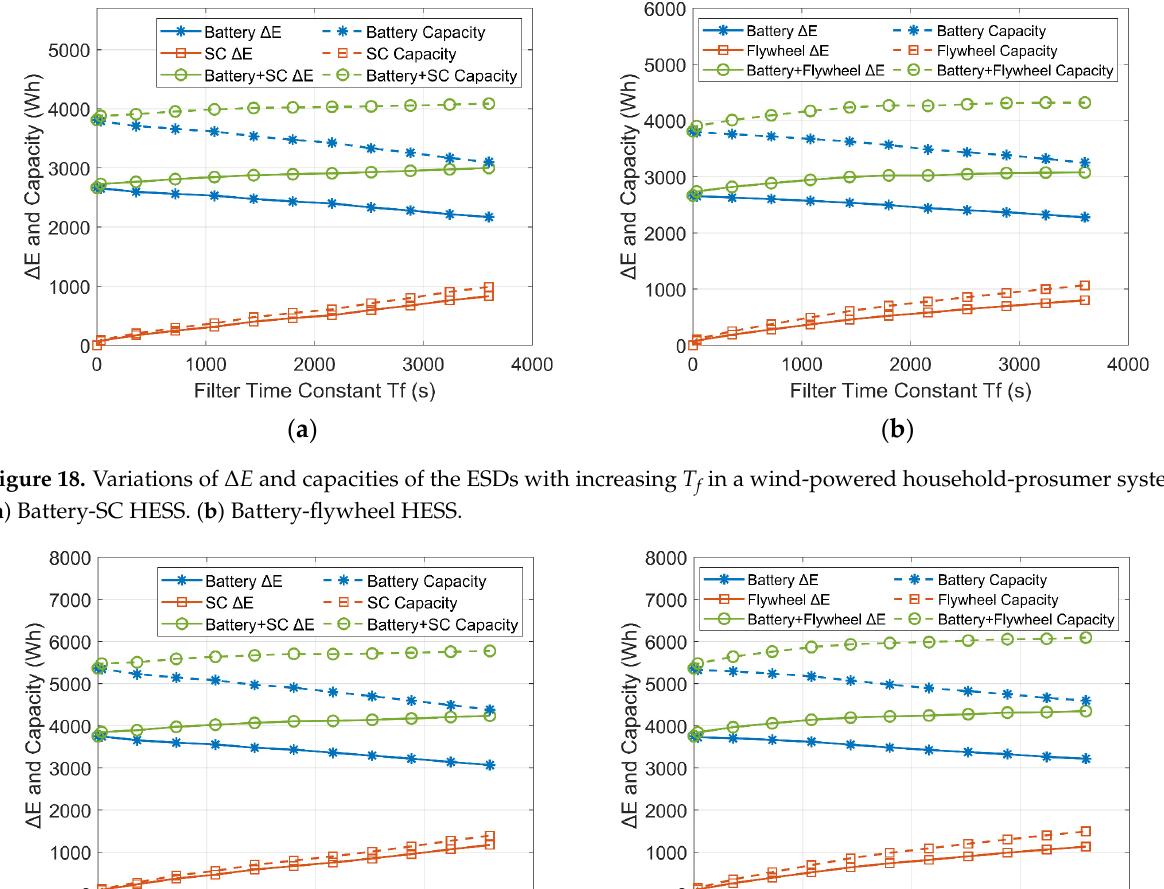
Figure 18. Variations of Δ E and capacities of the ESDs with increasing T f in a wind-powered household-prosumer system. ( a ) Battery-SC HESS. ( b ) Battery-flywheel HESS.